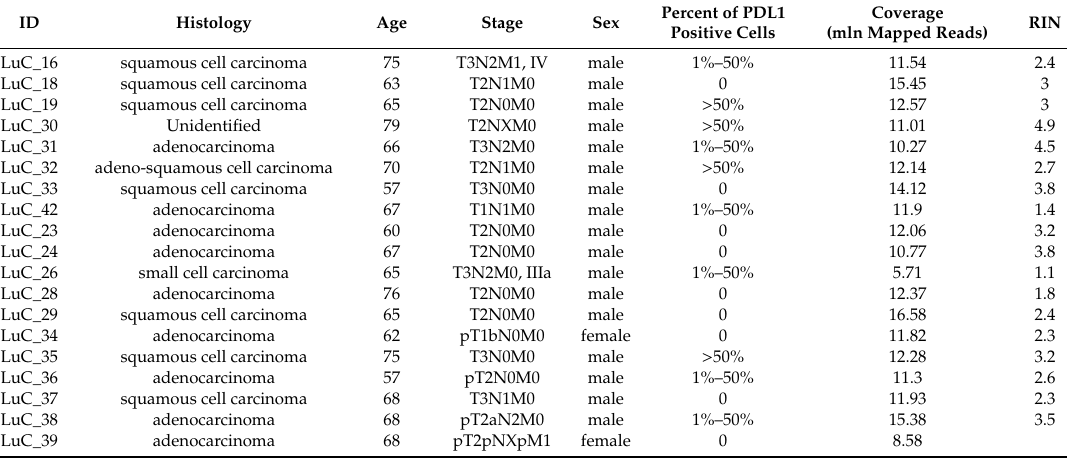
Table 2. Clinical and molecular annotation of the lung cancer